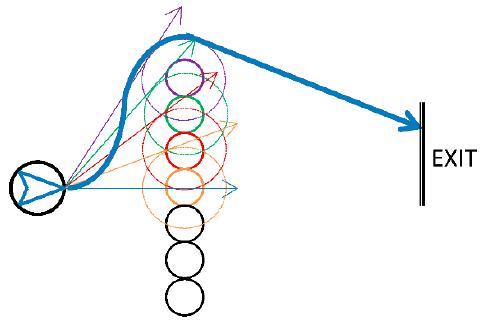
Figure 12. Schematic diagram of avoiding obstacles.